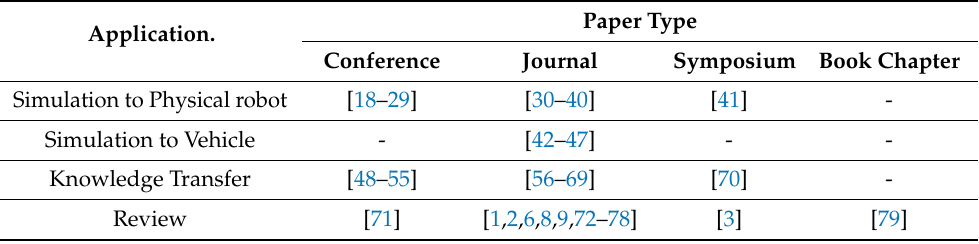
Table 3. List of papers selected after the mapping process. Application.